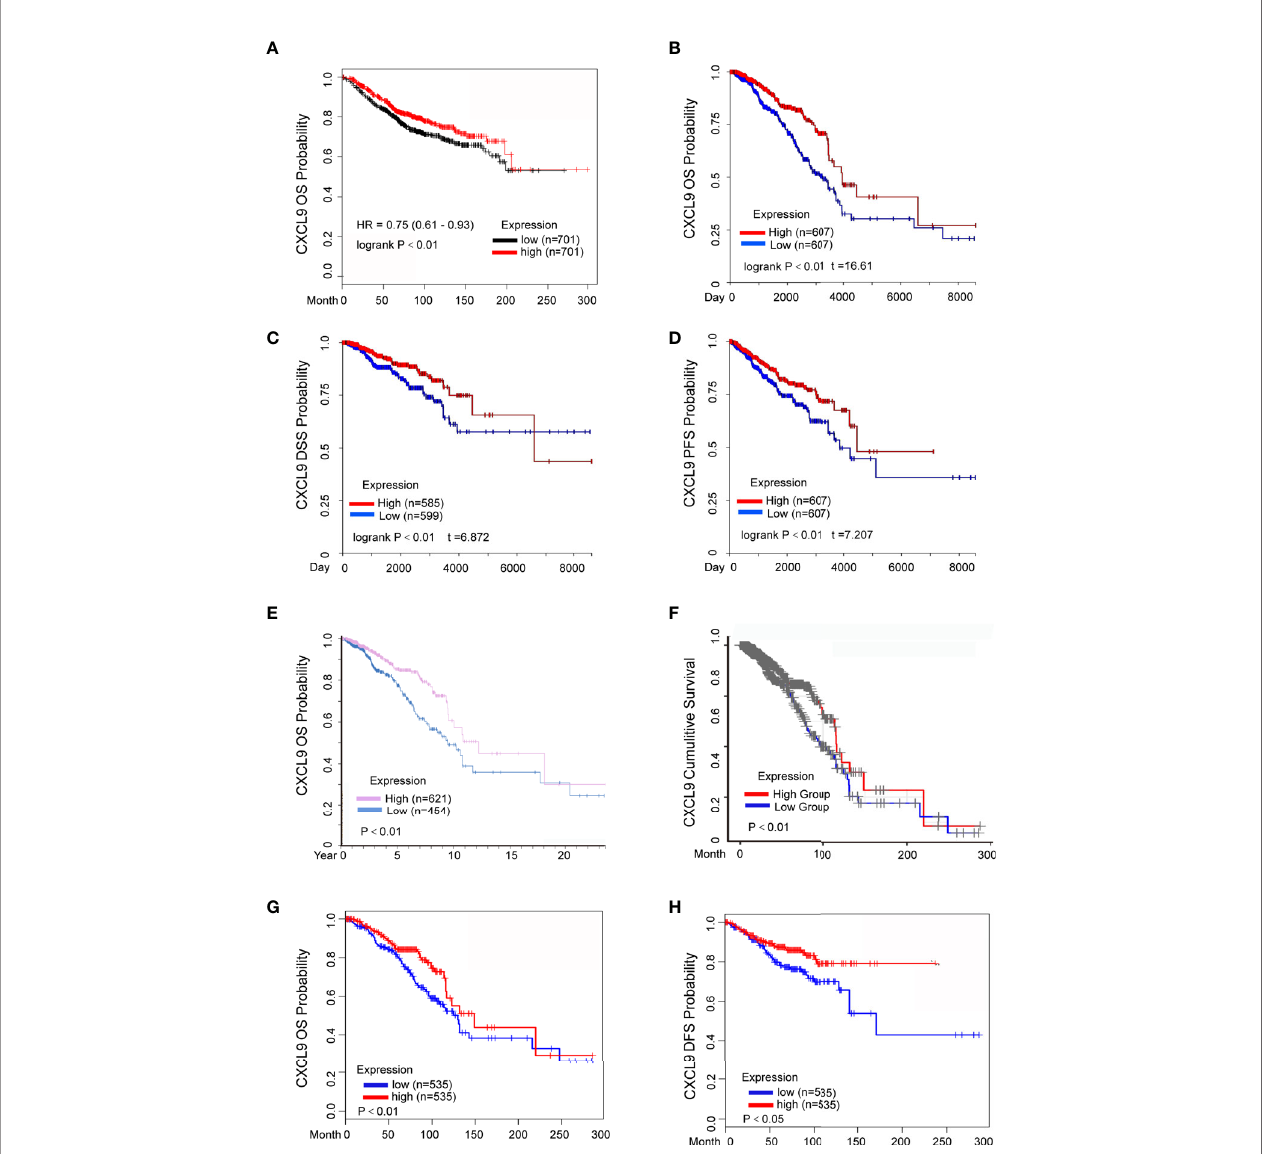
FIGURE 3 | Elevated CXCL9 expression predicted better survival status in BC patients. (A) Overall survival estimates for CXCL9 mRNA levels from Kaplan-Meier plotter database. (B – D) Overall survival (B) , disease speci fi c survival (C) , progression free survival (D) estimates for CXCL9 mRNA levels from UCSC Xena database. (E) Overall survival estimates for CXCL9 mRNA levels from Human Protein Atlas database. (F) Cumulative survival estimates for CXCL9 mRNA levels from TIMER database. (G, H) Overall survival (G) , disease free survival (H) estimates for CXCL9 mRNA levels from GEPIA2